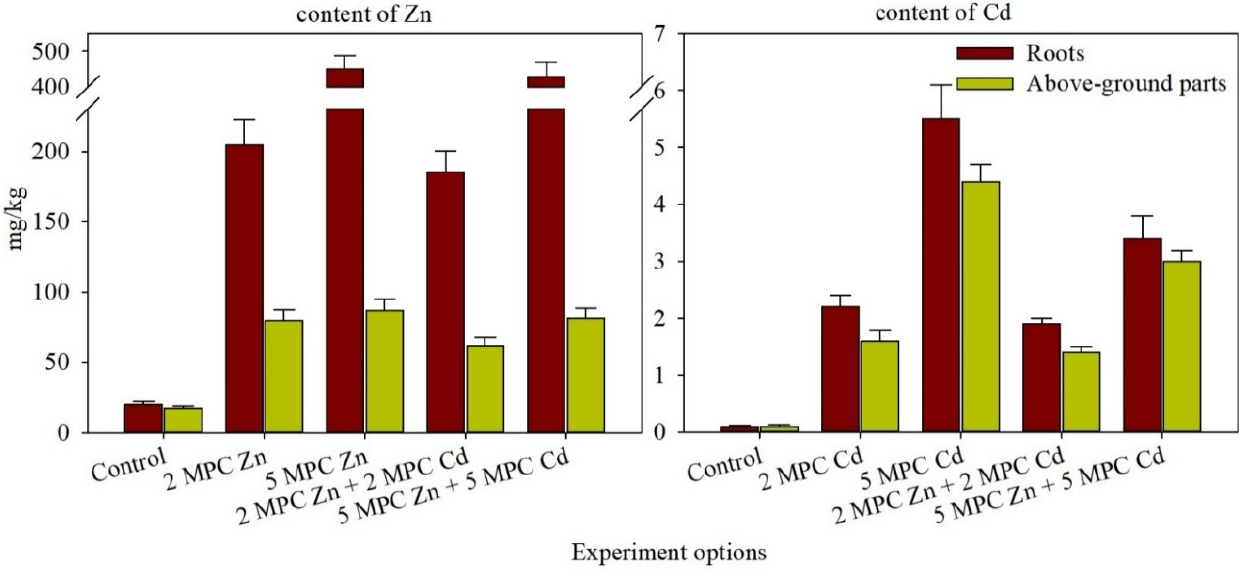
Figure 1. The metal content in various parts of H. vulgare grown in the soil spiked with different levels of Zn and Cd, individual and with combined metals, mg/kg . Above-ground parts of plants include stems and leaves.